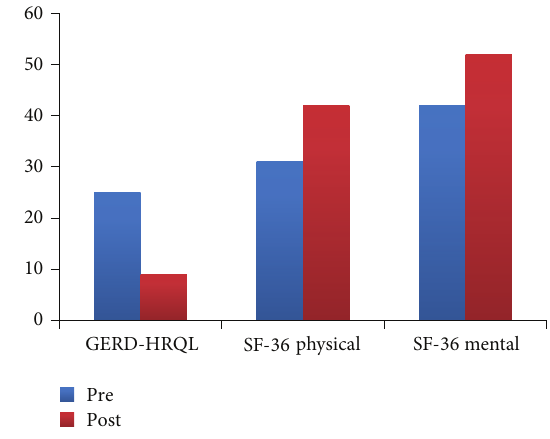
Figure 3: Scores before and after Stretta.